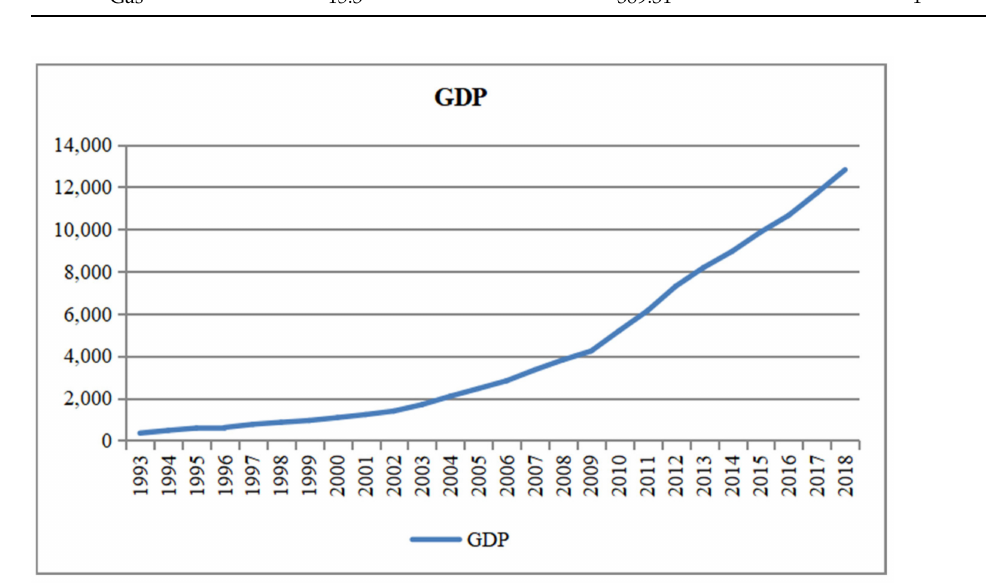
Figure 2. Growth trends in the GDP.